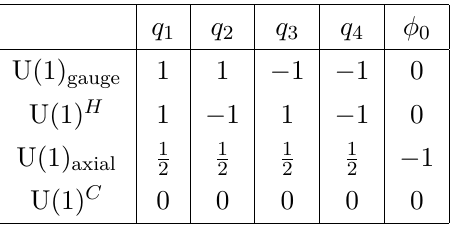
Table 3 . Charge assignment in T [SU(2)] theory. U(1) H , U(1) C and U(1) axial denote the Cartans of SU(2) H , SU(2) C and axial U(1) ⊂ SO(4)